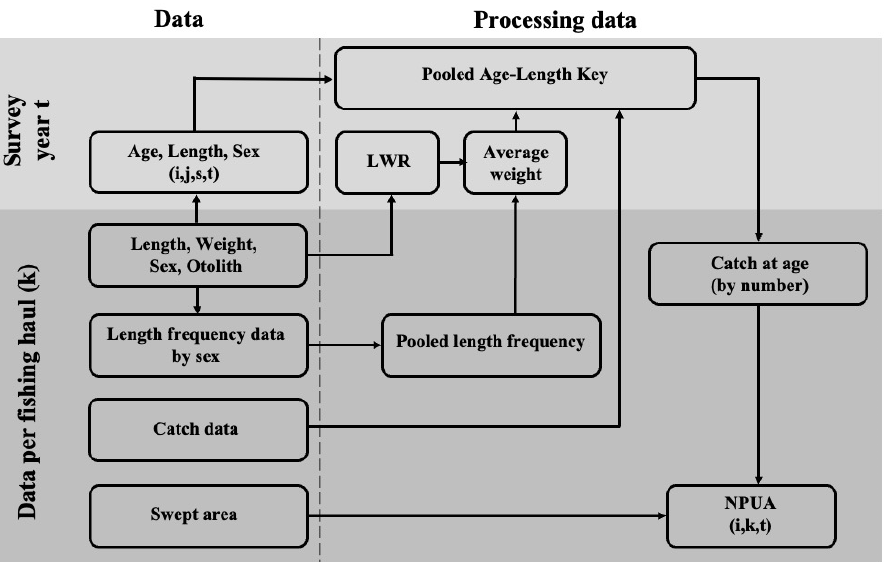
Figure 2. Survey data processing flow to obtain catch-at-age data, and hence an abundance index per age group i, fishing hauls k, and year t. Age (i), length (j), and sex (s) from fishing hauls allowed us to obtain a pooled age–length key (both sexes) for survey t, which was utilized to obtain catch at age from pooled length–frequency (both sexes). The abundance index is catch in number per unit of area, where the area is the swept area of each haul.